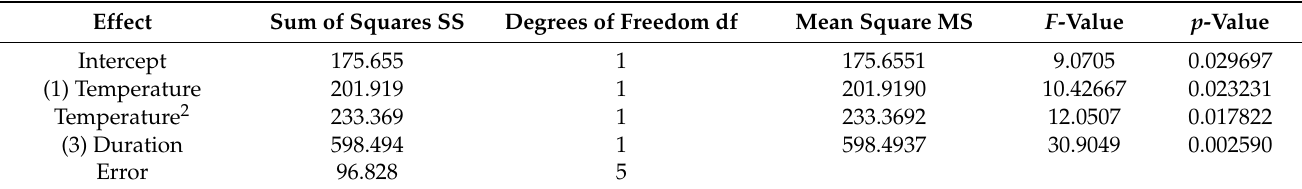
Table 8. Analysis of variance for the regression model of the thickness of the compact part of the boride layer.